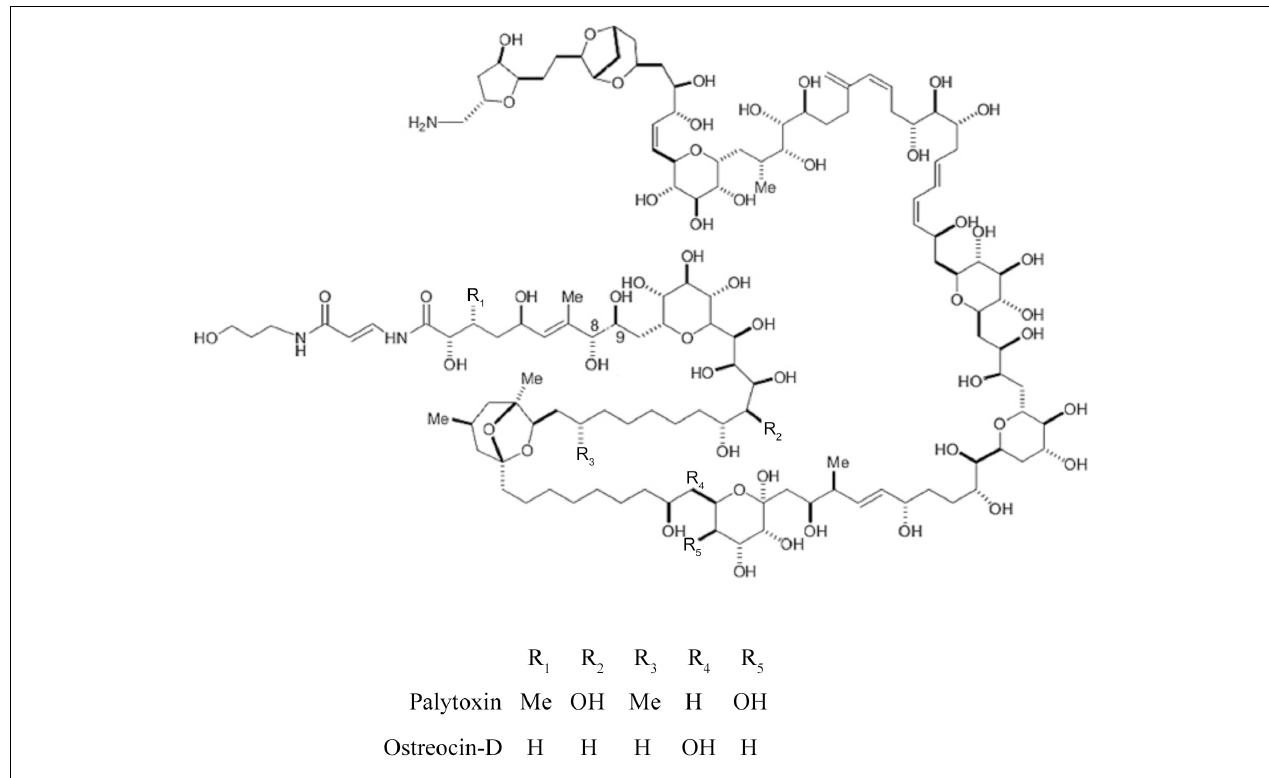
FIGURE 5 | Structures of palytoxin (PLTX) and ostreocin-D, produced by certain benthic members of the genus Ostreopsis (Amzil et al., 2012).